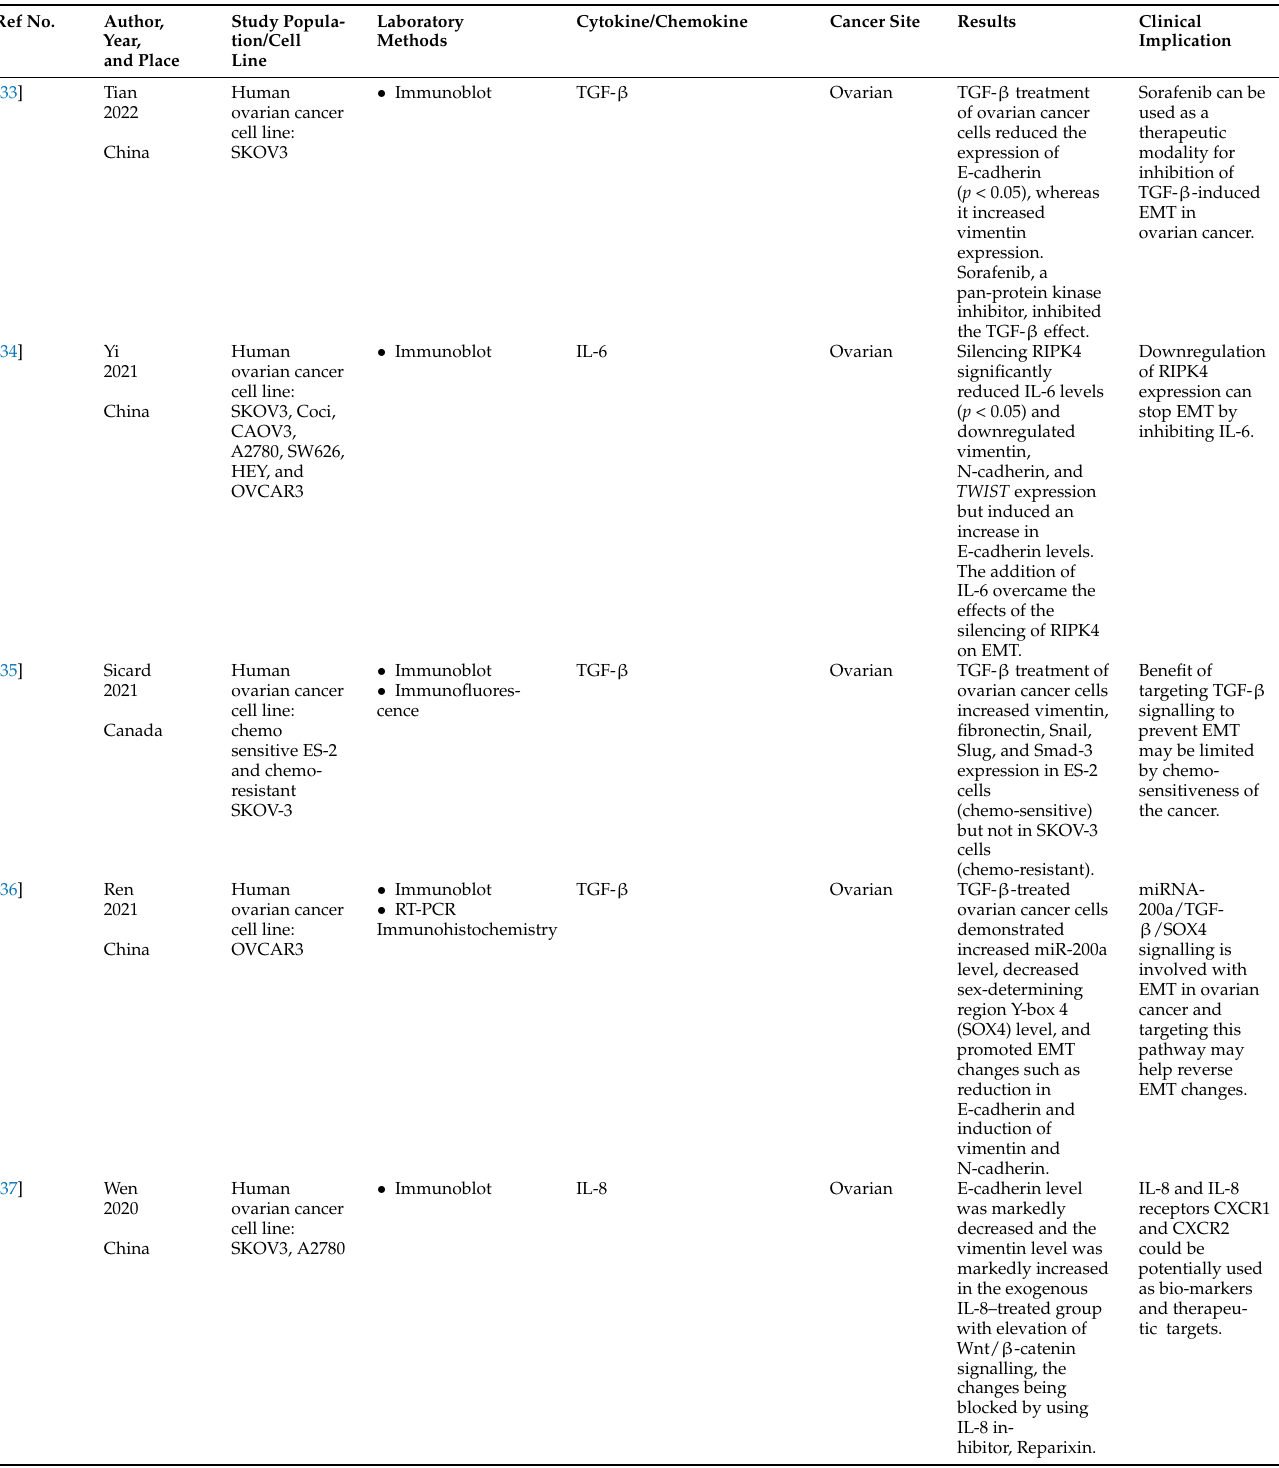
Table 1. Characteristics of articles included in the systematic